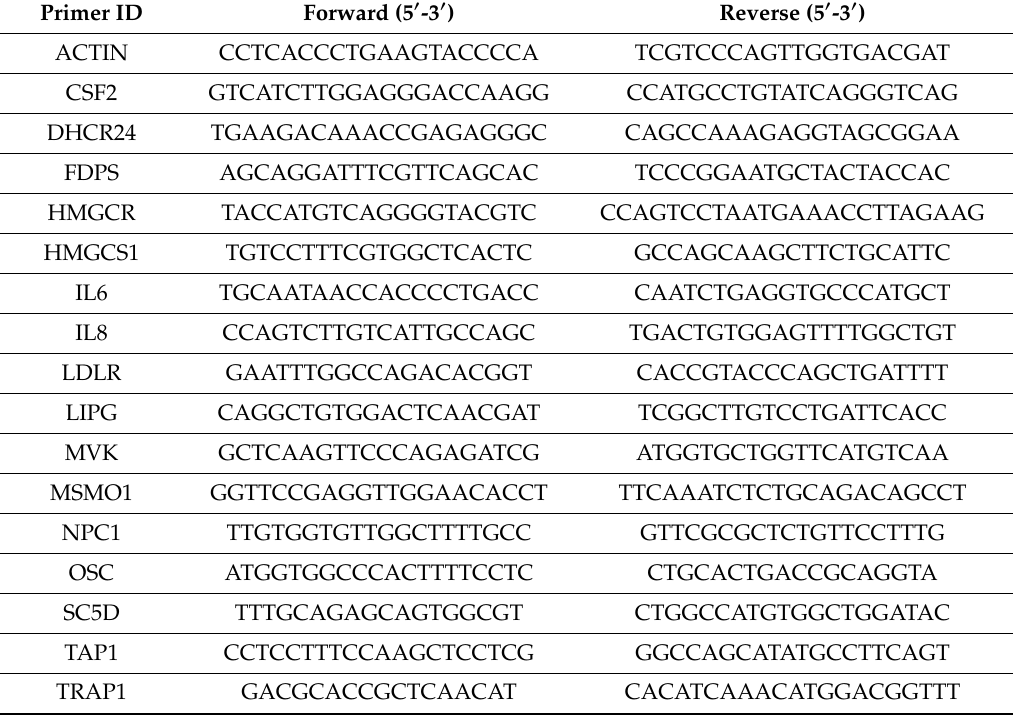
Primers used for quantitative PCR analyses. CSF2: Colony Stimulating Factor